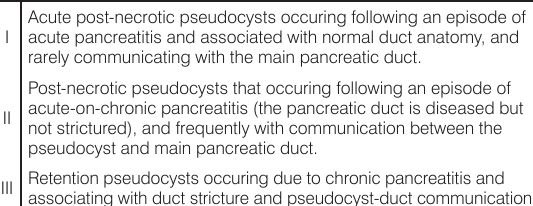
Table 1. Types of pancreatic pseudocysts according to D’Egidio and Schein’s classification.